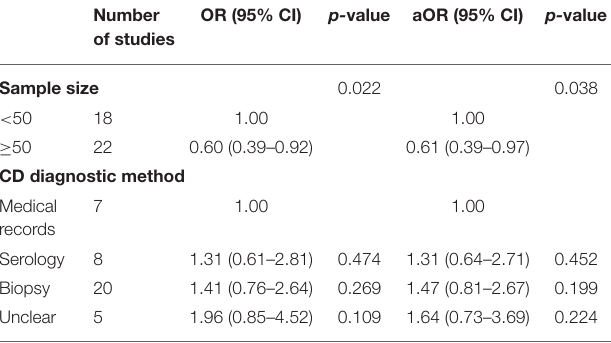
TABLE 3 | Univariate and multivariable meta-regression analyses to identify the sources of heterogeneity in studies reporting the prevalence of CD in patients with Turner syndrome based on different